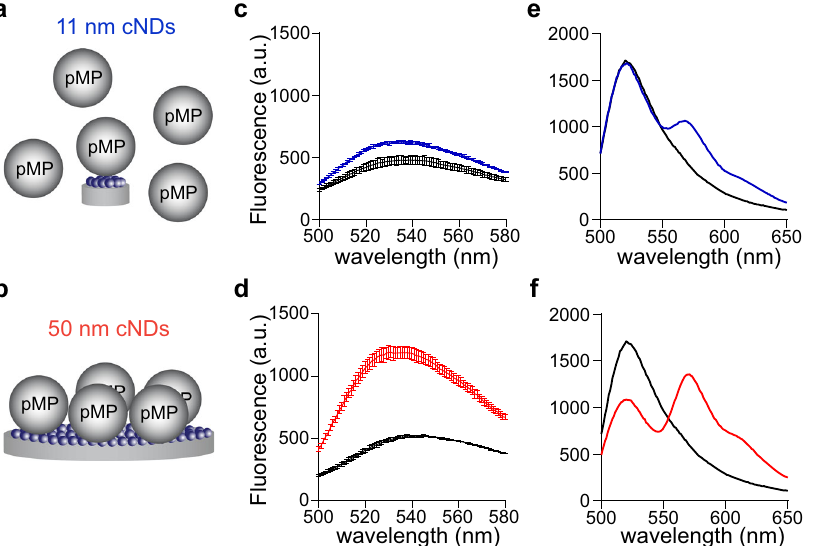
Fig. 6 Application of cNDs for characterization of protein-lipid interactions. a – b , Illustration of peripheral membrane protein (pMP) binding to small ( a ) and large ( b ) nanodiscs. c – d , Fluorescence emission spectrum of NBD-labeled syt1 (10 nM) in the absence (black) or presence of 11 ( c , blue) and 50 ( d , red) nm cNDs (1 µ M). e – f , Fluorescence emission spectrum of OG-labeled EIIA Glu (10 nM) in the absence (black) or presence of Dil-labeled 11 ( e , blue) and 50 ( f , red) nm cNDs (10 µ M). Data are shown as mean ± s.d., n = 3 independent experiments. a. u., arbitrary units. Source Data are available as a source data fi